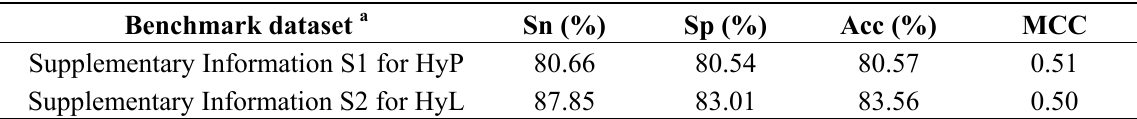
Table 1. The jackknife test results by the new predictor on the benchmark datasets in the Supplementary Information S1 and S2. HyP, hydroxyproline; HyL, hydroxylysine; Sn, sensitivity; Sp, specificity; Acc, accuracy; MCC, Matthews correlation coefficient.